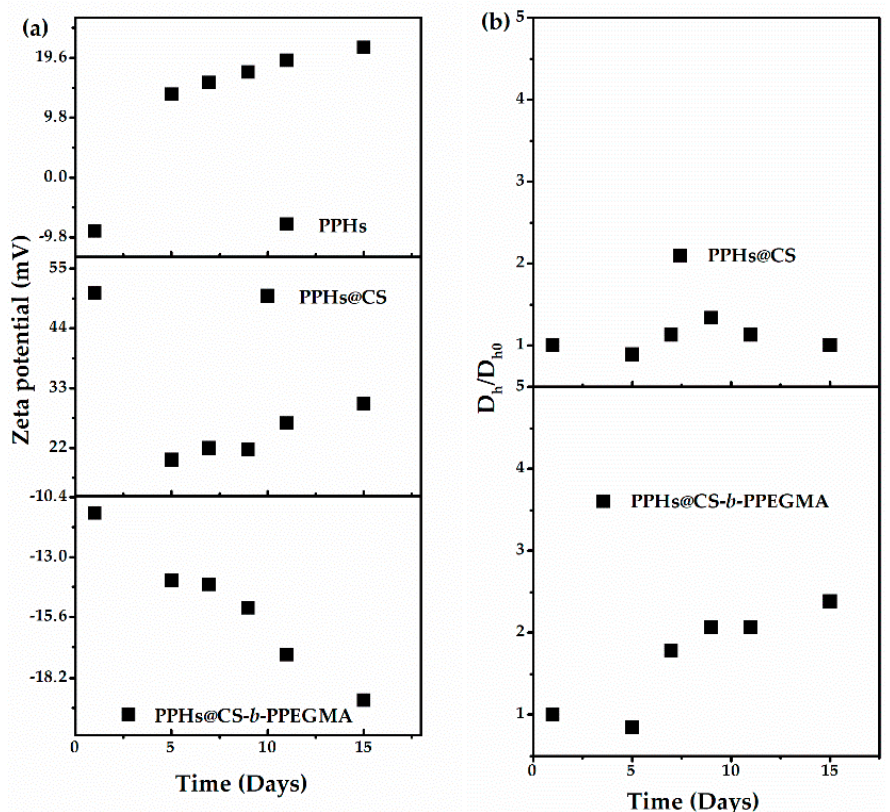
Figure 8. Stability study of systems loaded with phenolic compounds from L. graveolens zeta poten- tial ( a ) and particle size ( b ).